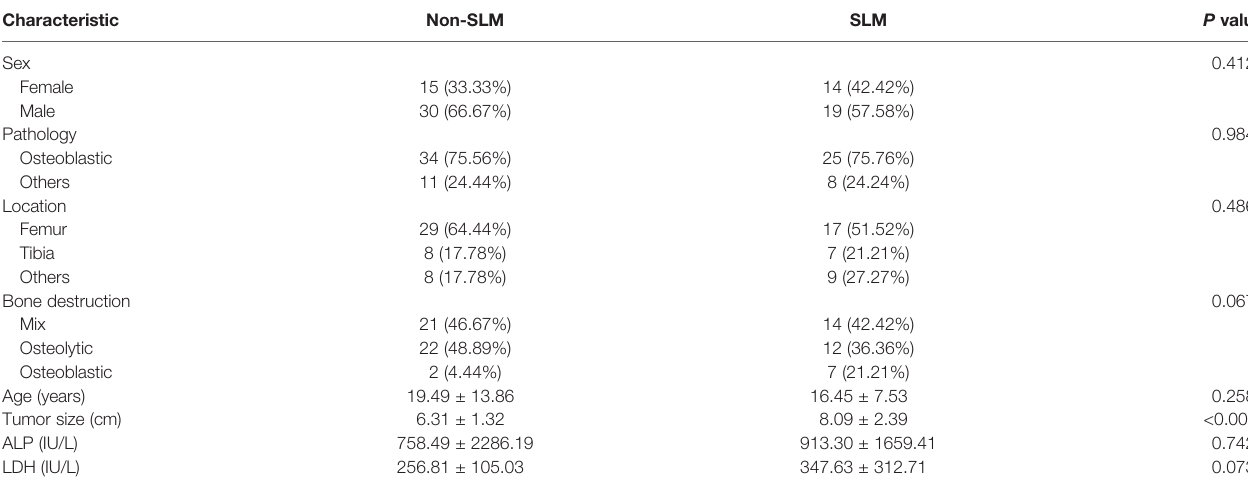
TABLE 1 | Clinical characteristics of 78 cases of osteosarcoma.